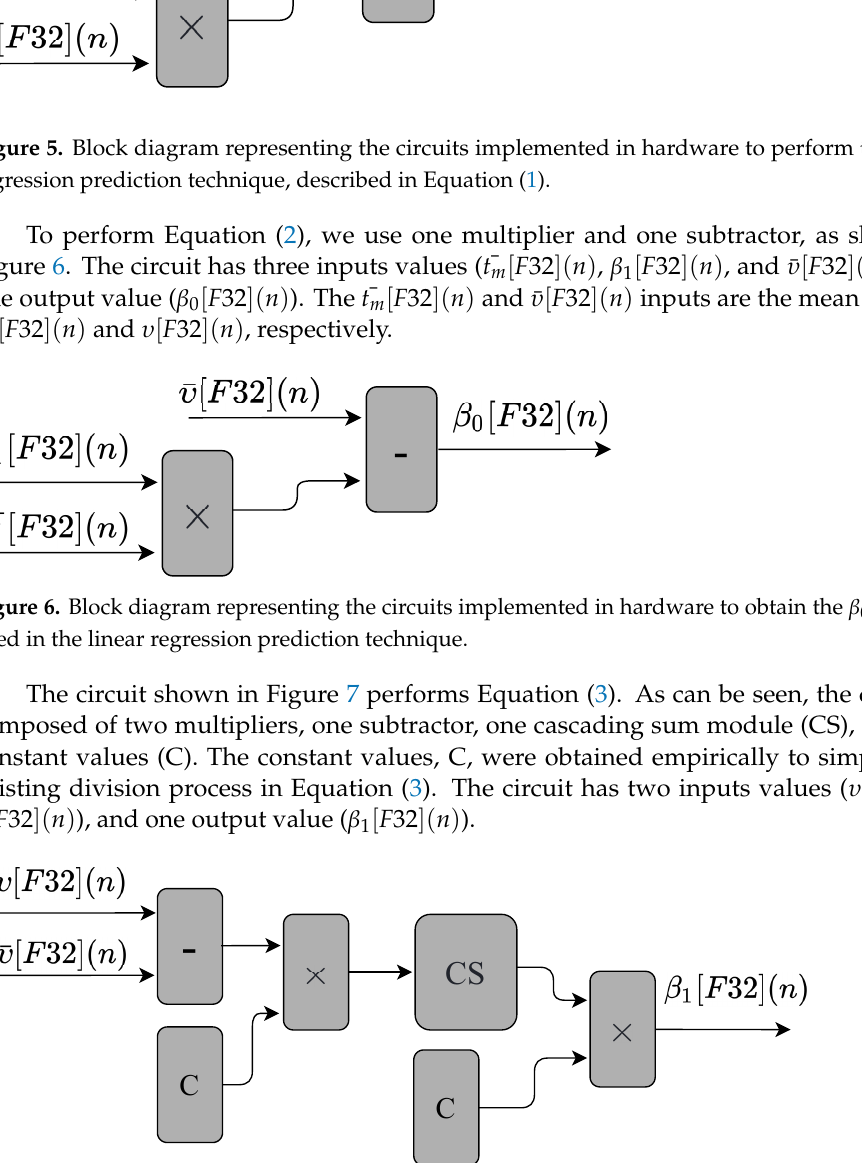
Figure 7. Block diagram representing the circuits and modules implemented in hardware to obtain the β 1 variable used in the linear regression prediction